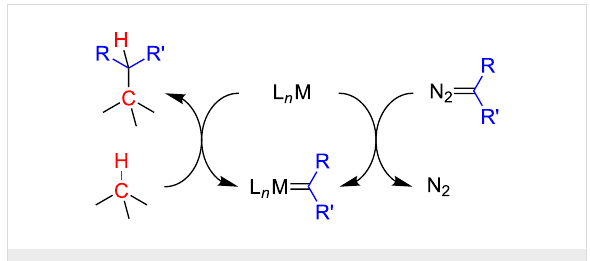
Scheme 7: Simplified mechanism of the carbenoid insertion into a C(sp 3 )–H